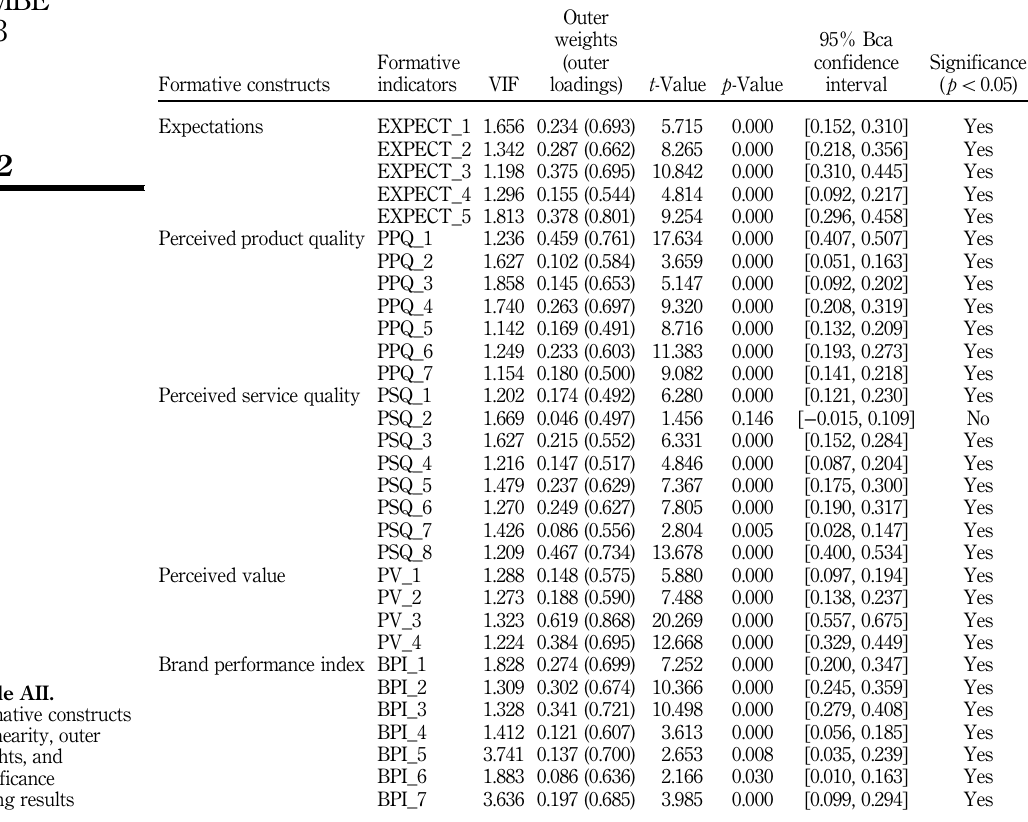
Table AII. Formative constructs collinearity, outer weights,